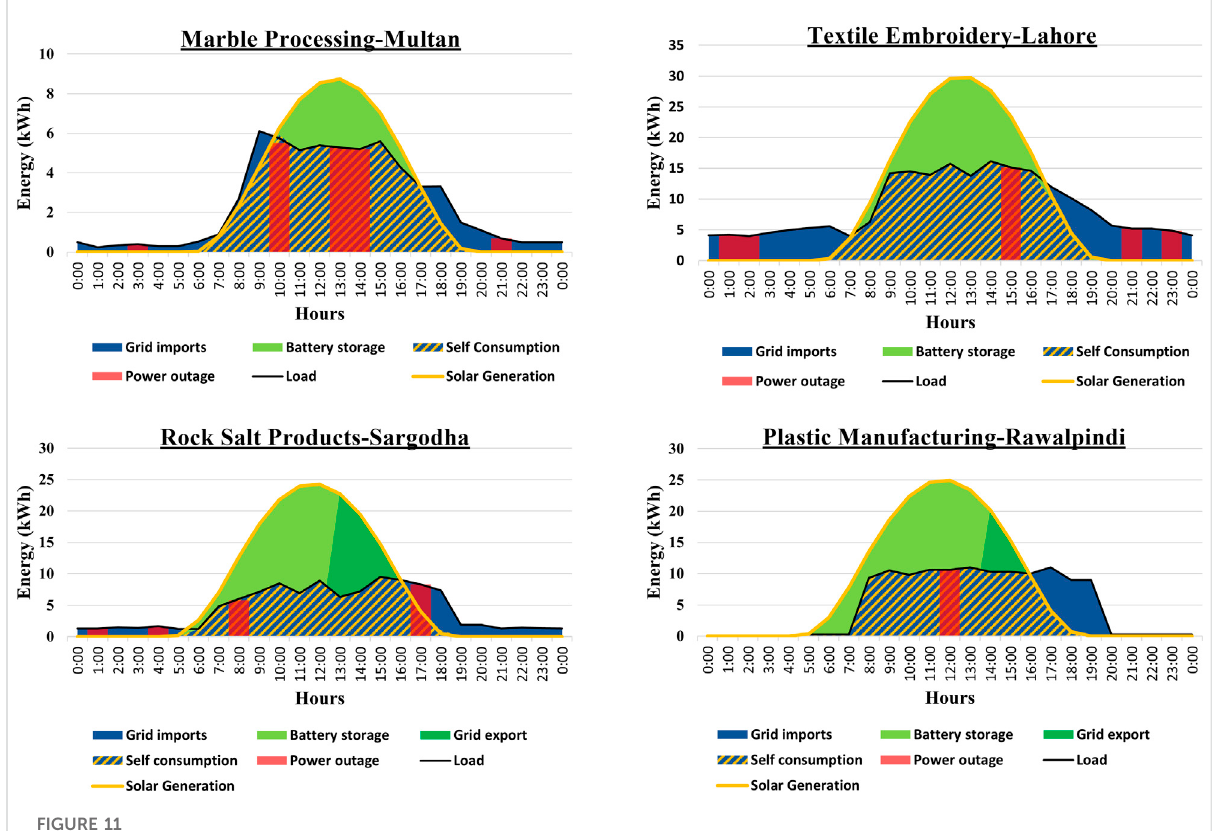
FIGURE 11 Typical daily solar generation and load curves of representative SMEs.